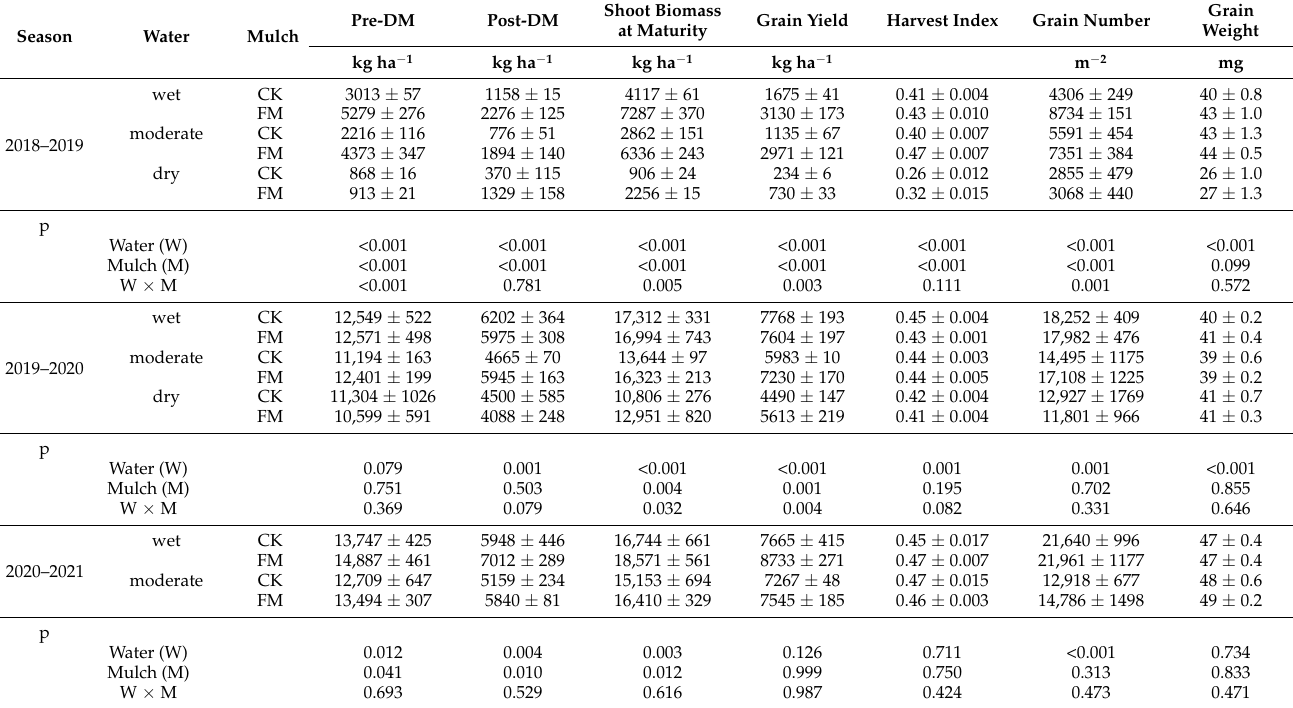
Table 1. Pre-anthesis dry matter (Pre-DM), post-anthesis dry matter (Post-DM), shoot biomass at maturity, grain yield, and yield components in a factorial study combining initial soil water (wet, moderate, dry), and mulch (CK, bare ground control; FM, plastic film mulching), and three